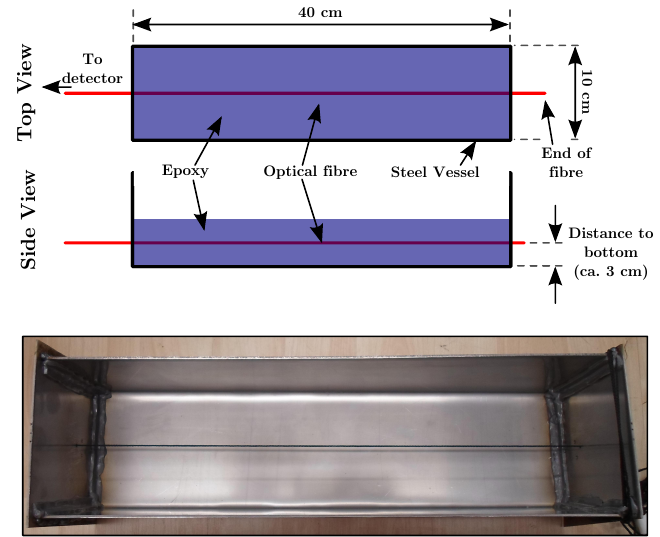
Figure 1. Upper image: schematical image of the experimental setup. Lower image: photo of the steel mold built to hold the epoxy during the experiment. The black thread visualizes the position of the optical fiber. The thread was replaced by the optical fiber before epoxy was cast into the